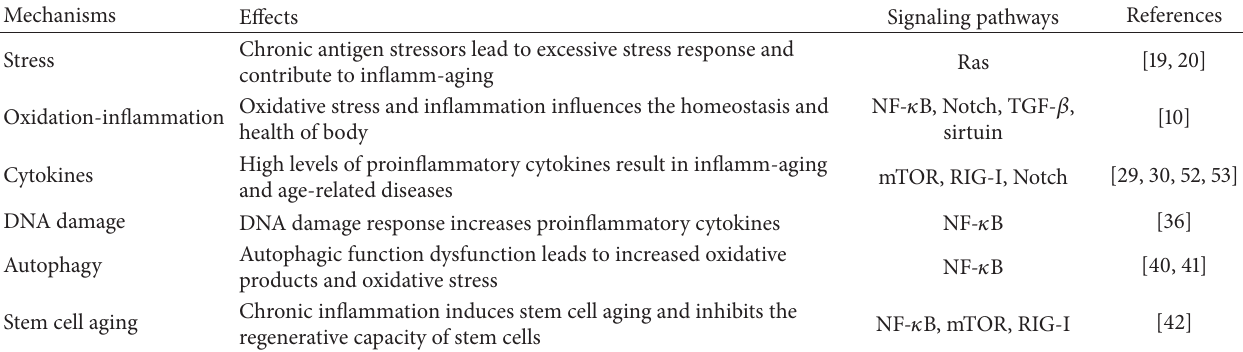
Table 1: Inflamm-aging-related mechanisms and regulated signaling